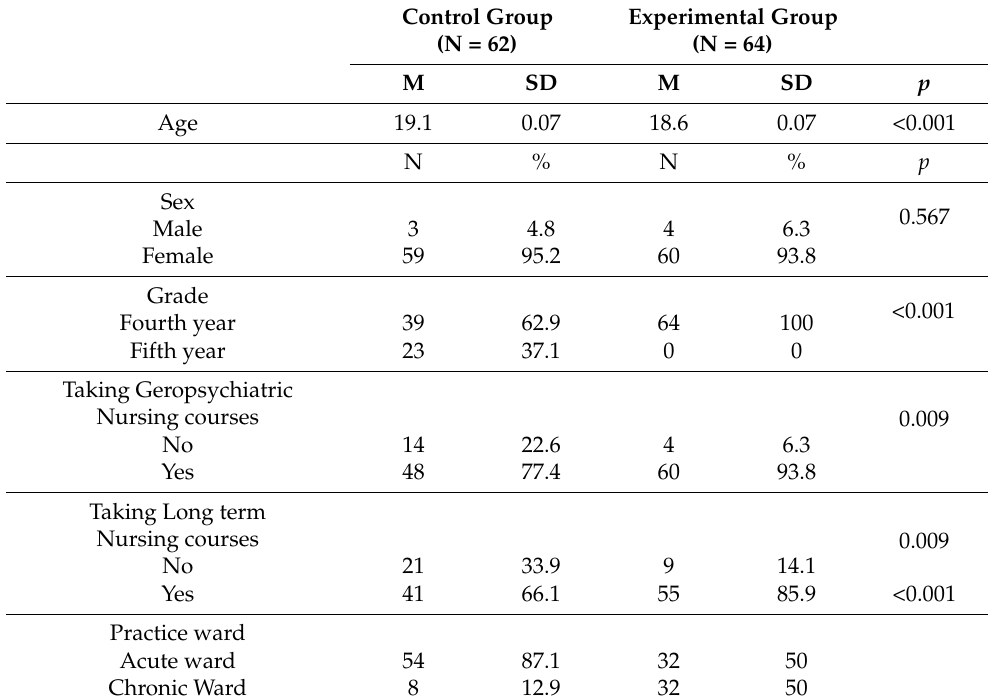
Table 1. Demographic characteristics of the participants (N =